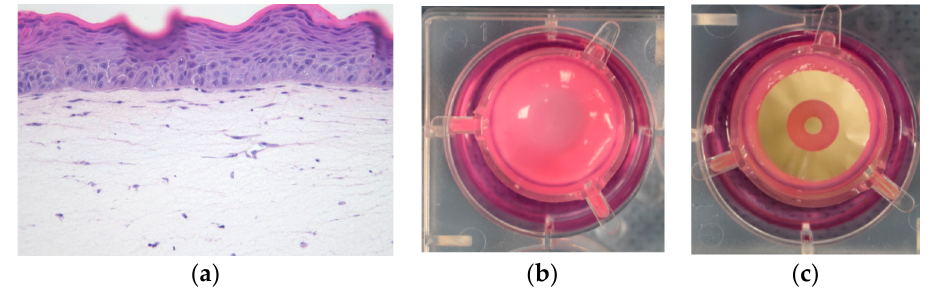
Figure 1. ( a ) Hematoxylin and eosin stained paraffin embedded living skin equivalent (Image courtesy of Innoven UK Ltd.); ( b ) The 24 mm diameter living skin equivalent model in use; ( c ) Tattoo sensor applied to the surface of Labskin.